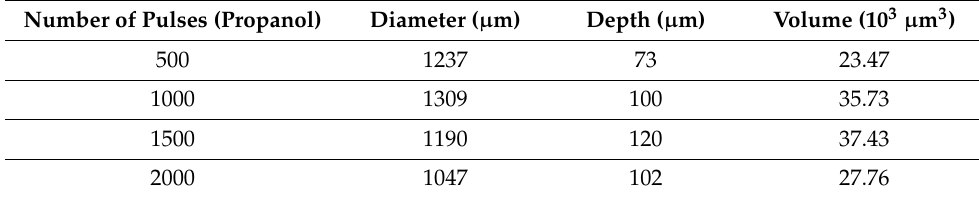
Table 2. The variation in ablated diameter, depth and ablated volume of laser-ablated Cd for 500, 1000, 1500 and 2000 laser pulses, at constant fluence of 3.6 J cm − 2 in propanol.